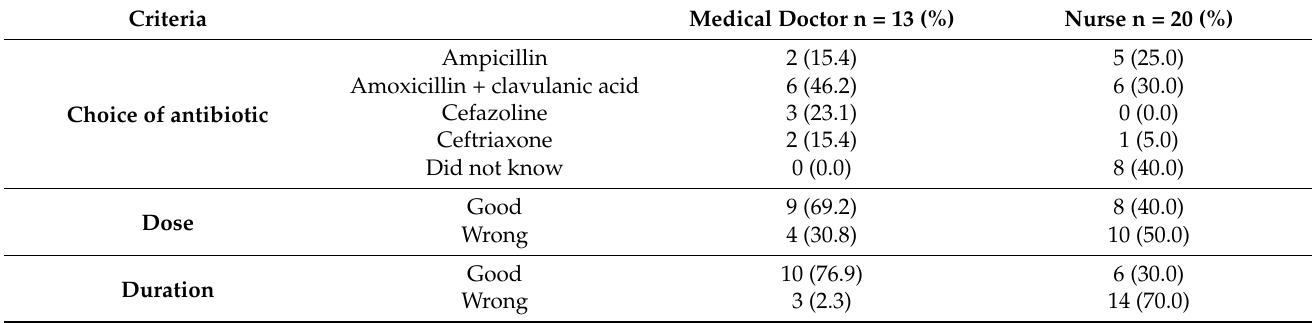
Table 2. Repartition of the scores of three criteria less-known according to socio-professional